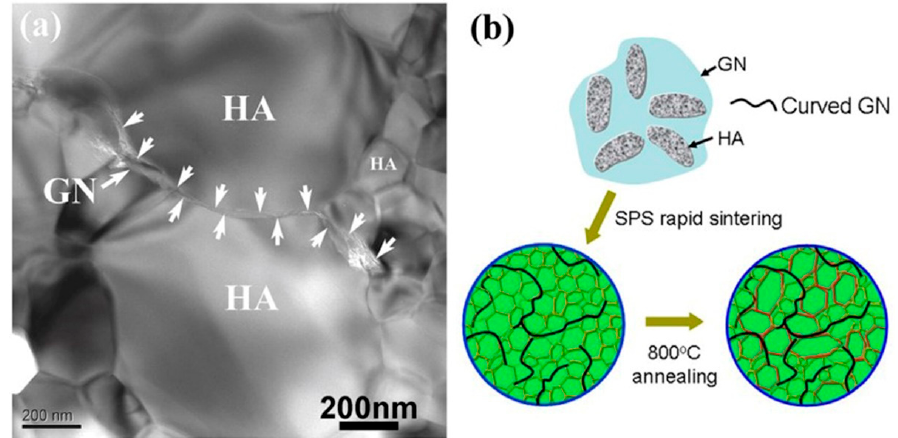
Figure 8. Restrained HA grain growth by GN(graphene nanosheet) and abnormal growth of the grain along the direction parallel to GN; ( a ) TEM image of the HA-GN composites showing that GN is predominantly located at the HA grain boundaries, forming a serial wall zones isolating individual HA grains, and abnormal HA grain growth is seen along the direction parallel to GN; and ( b ) schematic depiction of the composites illustrating evolvement of the HA grains during the SPS processing and following heat treatment [54].